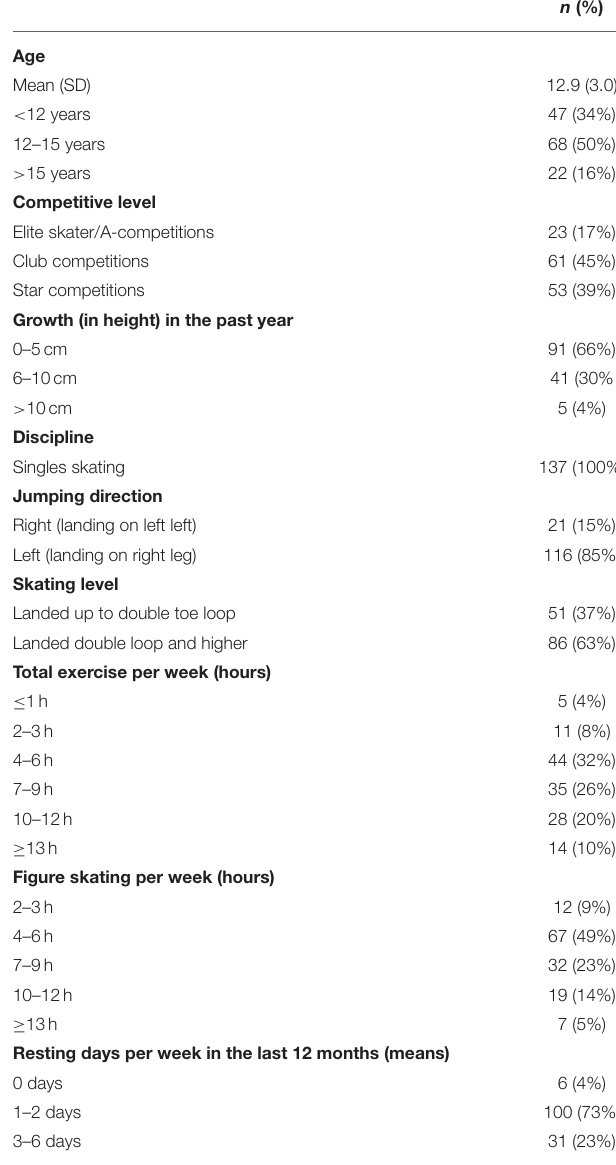
TABLE 1 | Characteristics of study population ( n =